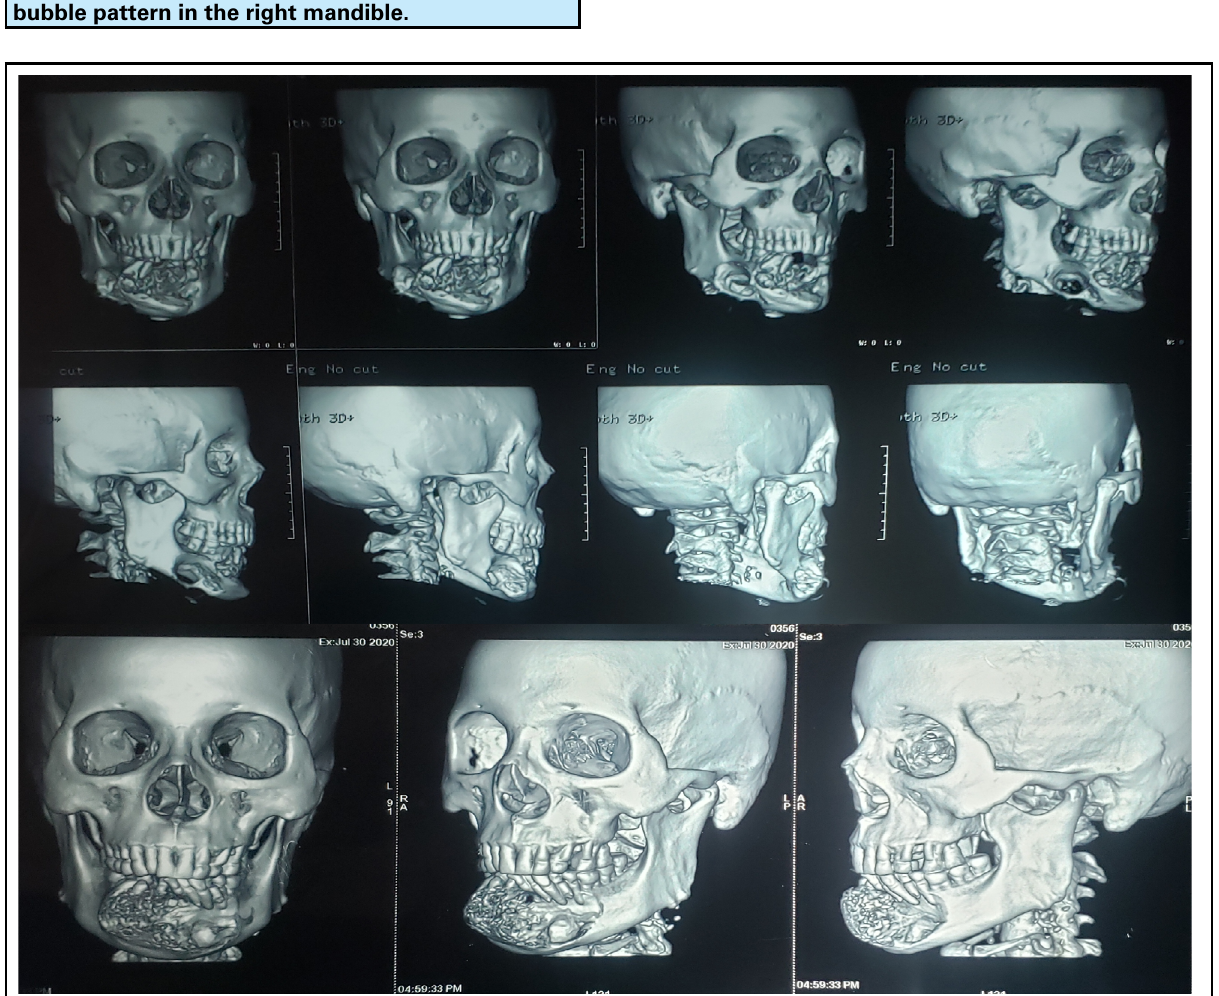
Figure 3. Three-dimensional reconstructed lesion in the